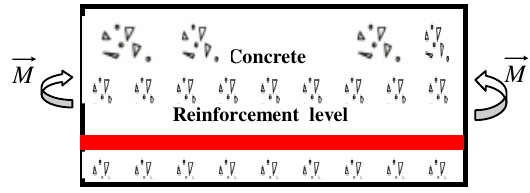
Fig. 3. Free body under bending effect